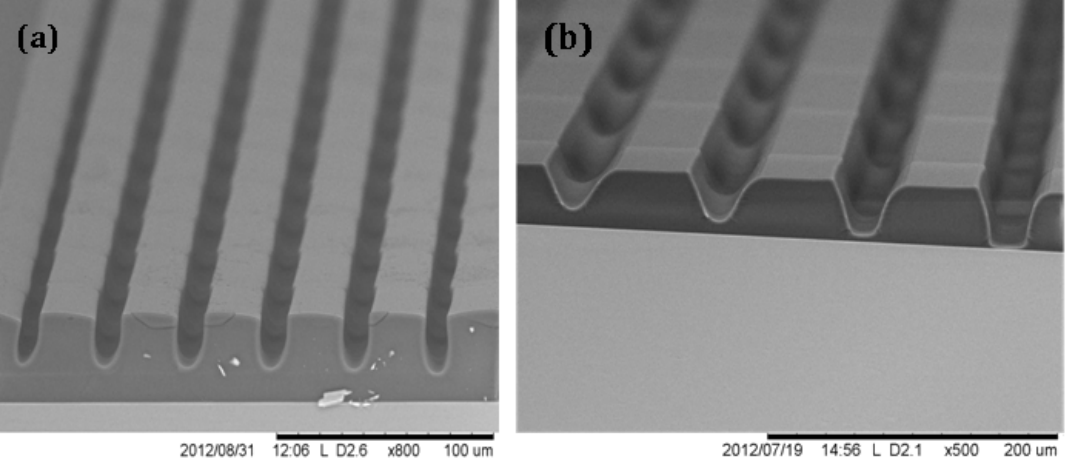
Figure 5. Over-exposed ORMOCOMP ® microstructures of ~40 µm height at 2000 rpm: ( a ) 1 µm spot size and effective dose of 2.7 J·cm −2 ; and ( b ) 4 µm spot size and effective dose of 1.8 J·cm −2